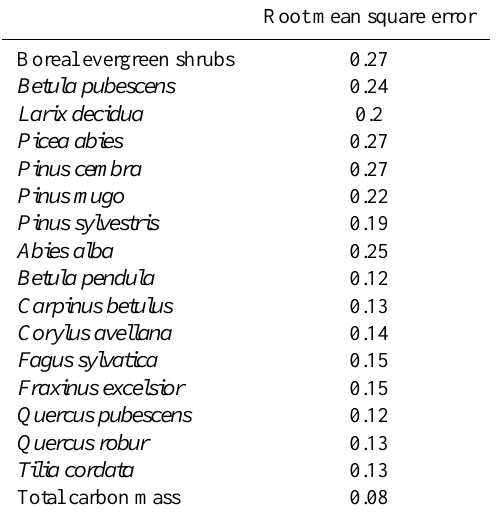
Table 1. Root Mean Square Error of the carbon mass between LPJ- GUESS results and GAPPARD results along the mapped transect. LPJ-GUESS used 100 stochastic replicates. Values were calculated as a mean of all simulated stands in between 1901 and 2100.